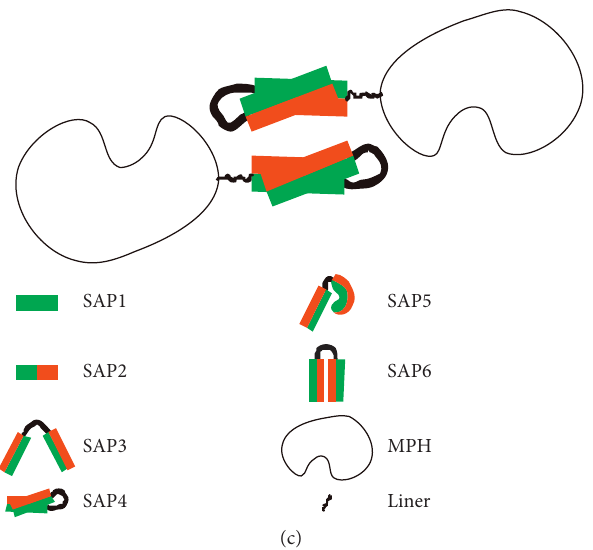
Figure 6: The patterns of oligomers mediated by different SAPs. The analysis of hydrophobic and hydrophilic amino acids shows the potential patterns of oligomers mediated by SAP2 (a), SAP3 (b), and SAP4 (c). The hydrophobic and hydrophilic regions are shown in brown and green,